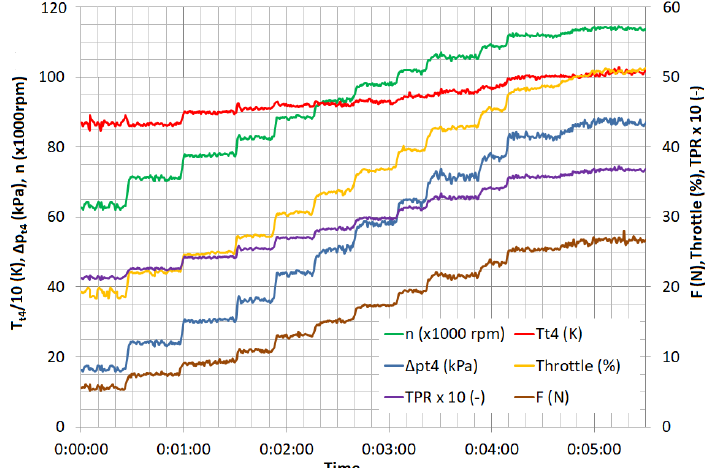
Figure 2. Measurement of the micro turbojet engine operational parameters for identification of LPV